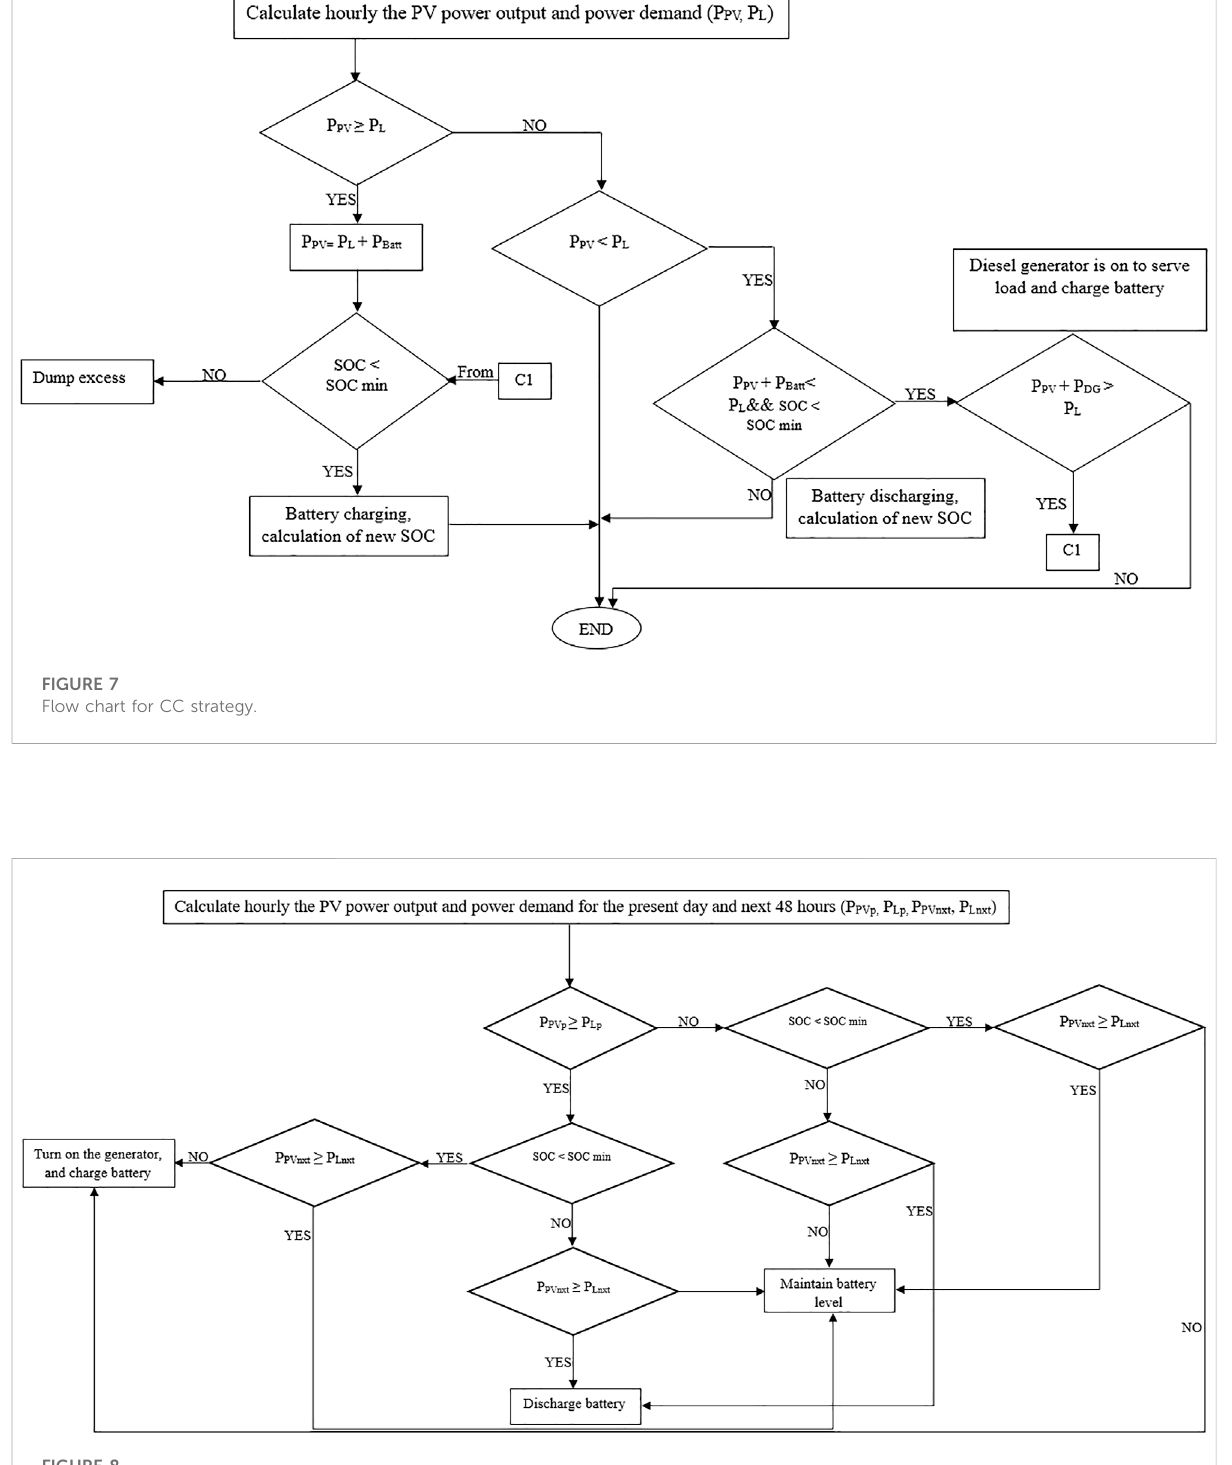
FIGURE 8 Flow chart for predictive control